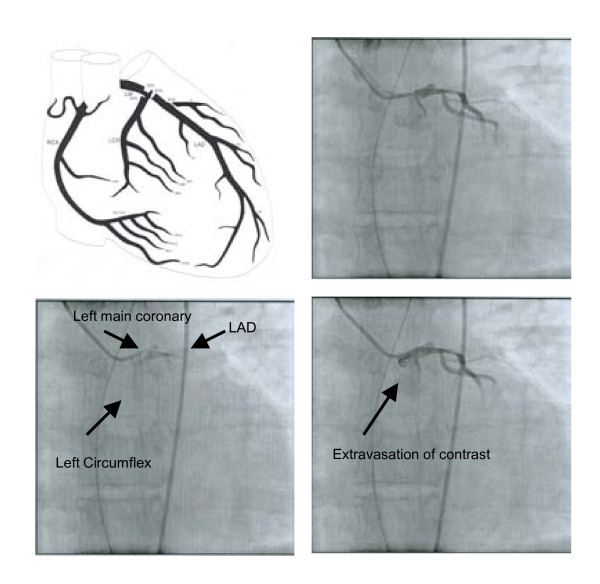
The angiogram demonstrates a 50% diffuse stenosis of distal left main artery with left main dissection. The LAD had 95% occlusion and 50% stenosis of the circumflex arteries. An intra-aortic balloon pump was placed and the patient was taken emergently to the operating room for coronary bypass.